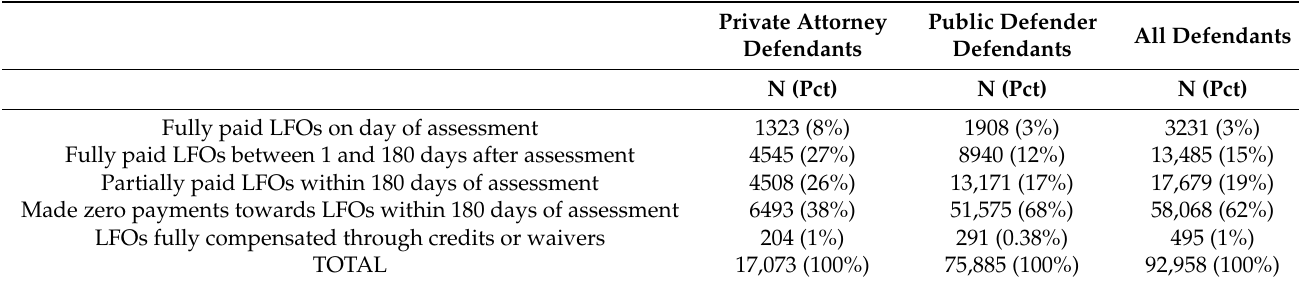
Table 3. Distribution of cases by LFO resolution or status within 180 days of assessment 13